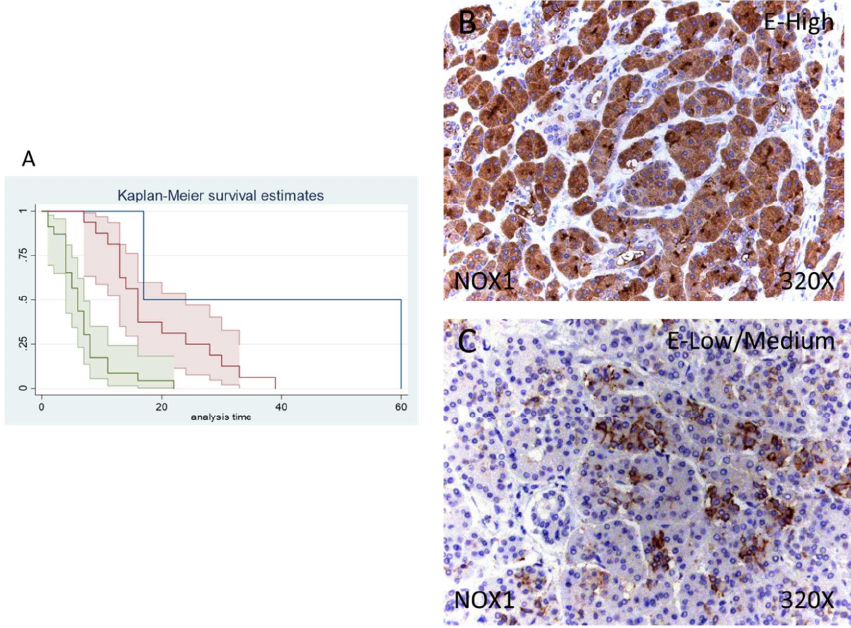
Figure 2. ( A ) Kaplan – Meier curves for survival time according to tumor expression of NOX1. Blue curve = tissue expression classified as negative, red curve = tissue expression classified as low/medium, green curve = tissue expression classified as high. ( B , C ) Images showing the protein expression of NOX1 in patients diagnosed with pancreatic cancer. In the case of NOX2 the percentage of patients with no expression of this component was 14.63%, whereas 34.15% of patients were low/moderate for NOX2 expression and 51.22% displayed a high NOX2 expression (Figure 3B,C).